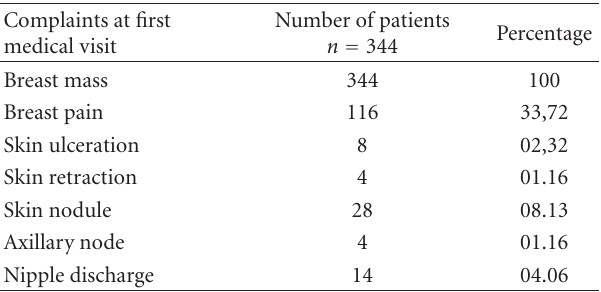
Figure 1: Yearly distribution of breast cancer patients followup at the Radiation Therapy Unit. Table 1: Complaints of breast cancer patients at first medical